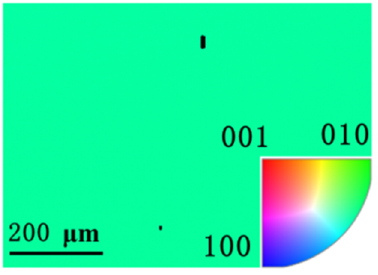
Figure 2. EBSD map of the the axis-oriented sections of (010)